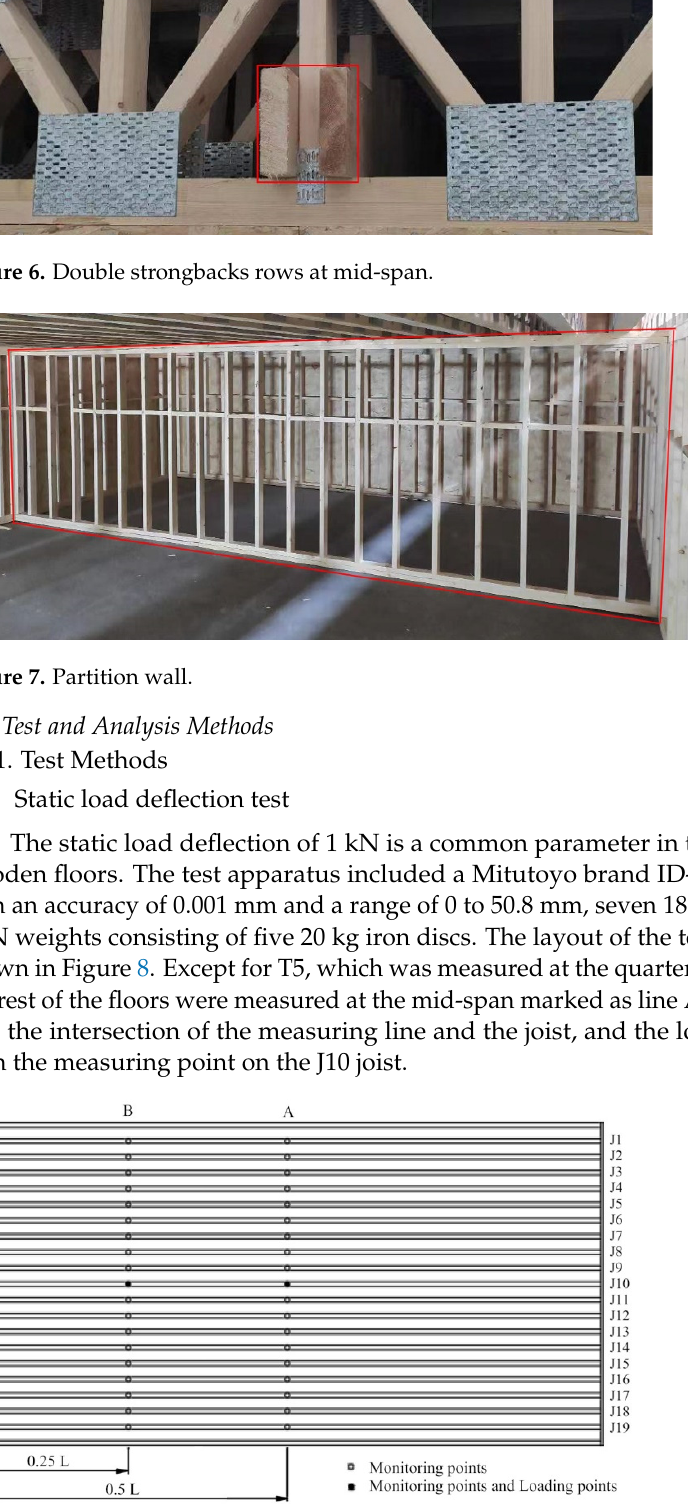
Figure 9. 1 kN static load deflection test. 2.